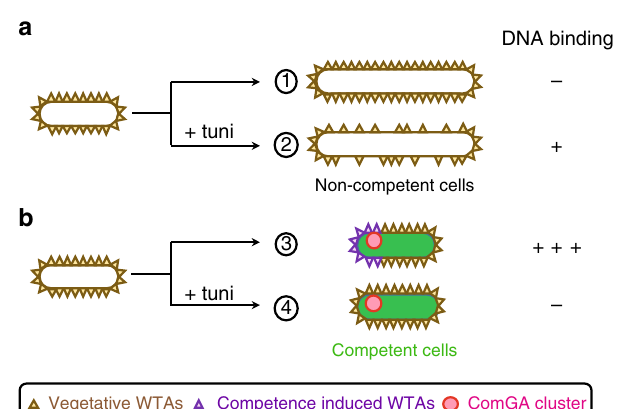
Fig. 5 Model for binding of exogenous DNA at the surface of B. subtilis cells. Schematic illustration of the differential distribution of vegetative WTAs and competence-induced WTAs at the surface of non-competent ( a ) and competent ( b ) cells, in the absence or in the presence of tunicamycin. a Non competent cells elongate and divide in the absence of tunicamycin, synthesizing new vegetative WTAs that decorate the cell surface and prevent DNA binding (1). In the presence of tunicamycin, synthesis of vegetative WTAs is inhibited and cells elongate anarchically (2). This creates regions in the cell surface where WTAs are diluted or absent, revealing a low af fi nity DNA binding site. b Cells developing competence do not elongate. In the absence of tunicamycin they synthesize competence- speci fi c tailored WTAs, which promote high af fi nity DNA binding at the vicinity of ComGA clusters (3). In the presence of tunicamycin, such competence-speci fi c tailored WTAs are not synthesized preventing high af fi nity DNA binding. Because vegetative WTAs are not diluted, they keep preventing low af fi nity DNA binding at the cell surface